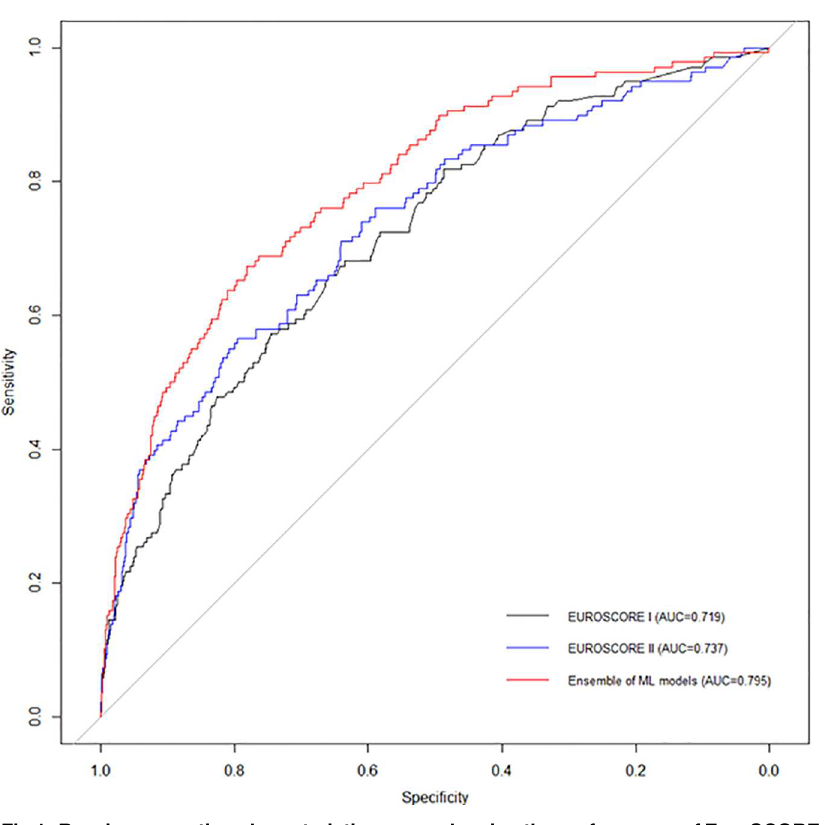
Fig 1. Receiveroperating characteristic curves showing the performance of EuroSCORE I, EuroSCORE II, and the ML model in predicting post-operative mortality. Areas under curves (95% CI) are 0.719 (0.674–0.763), 0.737 (0.691–0.783), and 0.795 (0.755–0.834), respectively.